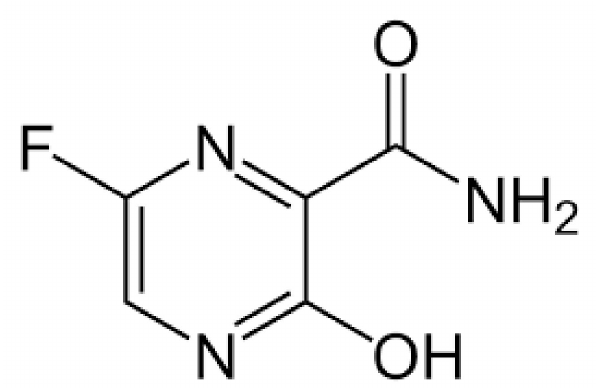
Figure 11. Structure of Favipiravir.